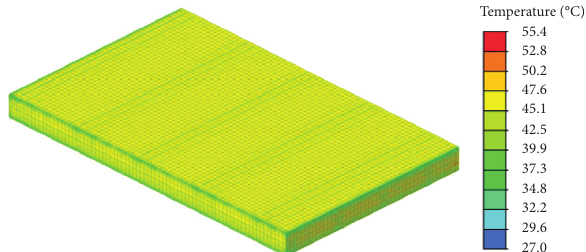
Figure 7: Time-history curve of concrete temperature in the first layer of cap.